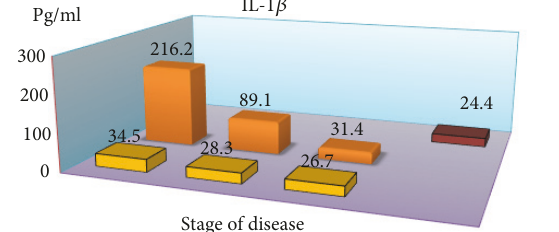
Figure 4: Dynamics of indicators of proinflammatory cytokines (IL-6) in children with malaria.